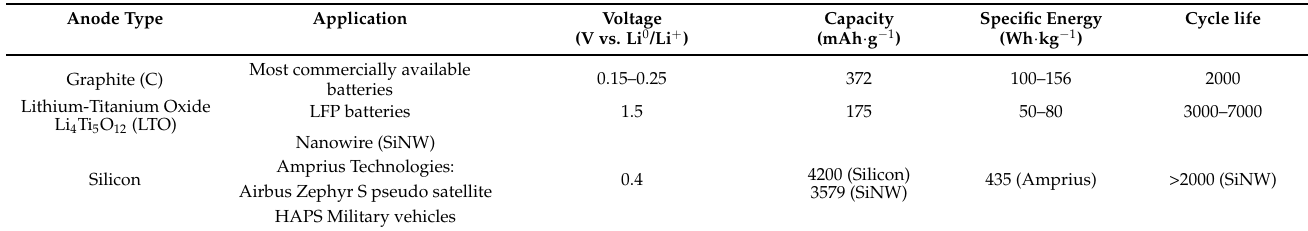
Table 4. Commercially available anodes and their main